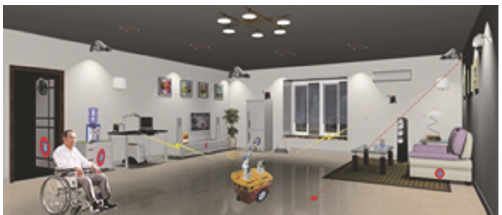
Figure 1: Illustration of intelligent space